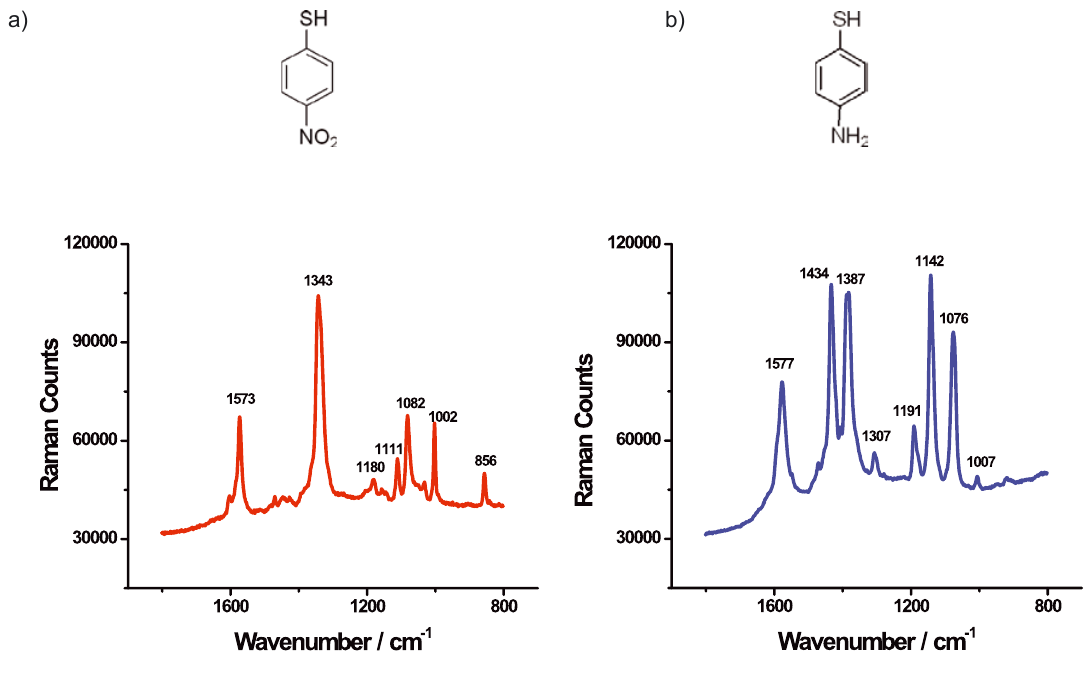
Figure 4. SERS spectrum of (a) 4-NBT and (b) 4-ABT adsorbed on a templated gold film produced using 600 nm polystyrene spheres and grown to a thickness of 450 nm. The spectrum was taken using 633 nm HeNe laser, 3 mW power, single 10 s accumulation.